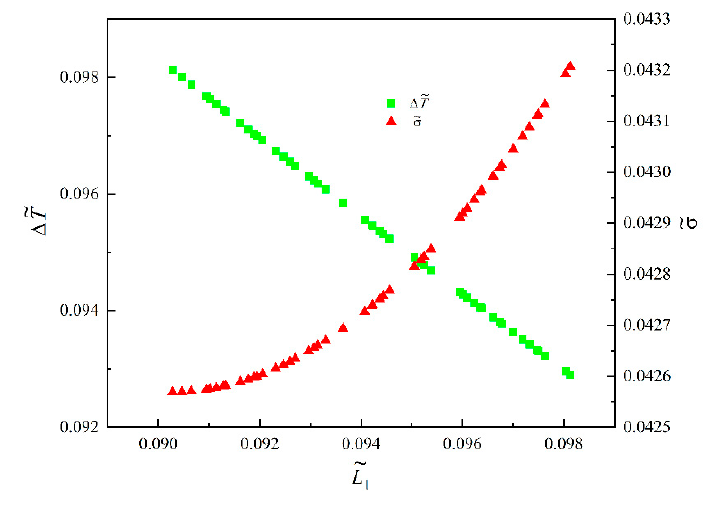
Figure 2. Pareto frontiers of ∆ (cid:101) T and (cid:101) σ with MOO under single-DOF optimization.